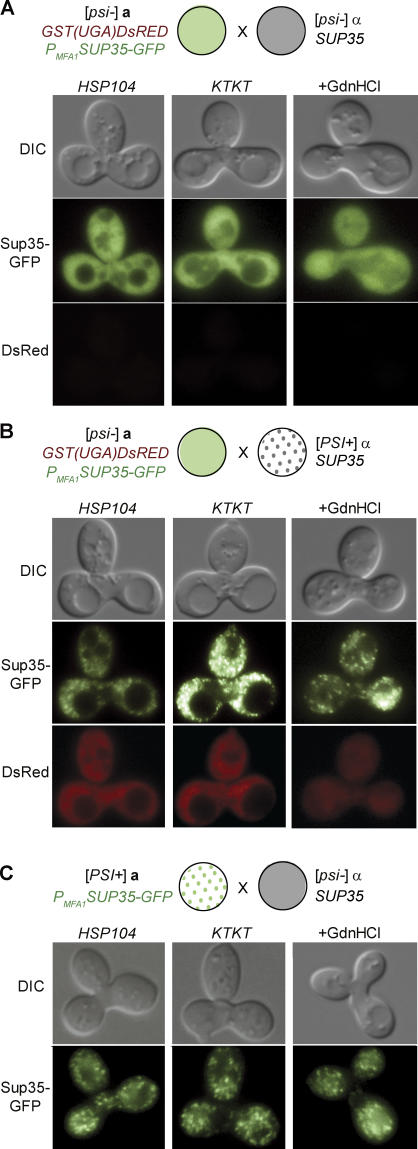
Efficient Incorporation of Sup35-GFP[psi−] into Existing Sup35[PSI+] Complexes Is Hsp104 Independent(A) MATa [psi−] haploids expressing untagged SUP35 from its endogenous locus, SUP35-GFP (green) from PMFA1 and GST(UGA)DsRED from PGPD were mated to MATα [psi−] haploids constitutively expressing untagged SUP35 (gray) in the presence or absence of functional Hsp104 as shown in the schematic diagram (top). The Sup35-GFP and DsRed fluorescence patterns were then examined in isolated zygotes. Since PMFA1 is repressed upon mating [43], green fluorescence is derived from existing Sup35-GFP. Images of a representative zygote (n ≥ 5) from a wild-type cross (SY874 × 74D-694 MATα; left), from a cross in which the MATa [psi−] mating partner contained a KTKT chromosomal replacement (SY876 × 74D-694 MATα; middle) or from a wild-type cross (SY874 × 74D-694 MATα) in the presence of GdnHCl (right) are shown.(B) MATa [psi−] haploids constitutively expressing untagged SUP35 and GST(UGA)DsRED, and SUP35-GFP (green) from PMFA1 were mated to MATα [PSI+] haploids constitutively expressing untagged SUP35 (gray dots) in the presence or absence of functional Hsp104 as shown in the diagram (top). Sup35-GFP and DsRed fluorescence were examined in isolated zygotes (n = 50). Images of representative zygotes from a wild-type cross (SY874 × 74D-694 MATα; left), from a cross in which the MATa [psi−] mating partner contained a KTKT chromosomal replacement (SY876 × 74D-694 MATα; middle), or from a wild-type cross (SY874 × 74D-694 MATα) in the presence of GdnHCl (right) are shown.(C) MATa [PSI+] PMFA1 SUP35-GFP haploids were mated to MATα [psi−] haploids constitutively expressing SUP35 (gray) in the presence or absence of Hsp104 function, as indicated in the diagram (top). Images of a representative zygote (n ≥ 13) from a wild-type cross (SY597 × SY582; left), from a cross in which the MATα [psi−] mating partner contained a KTKT chromosomal replacement (SY597 × SY776 middle), or from a wild-type cross in the presence of GdnHCl (SY597 × SY582; right) are shown. The formation of zygotes was confirmed by sporulation (unpublished data).